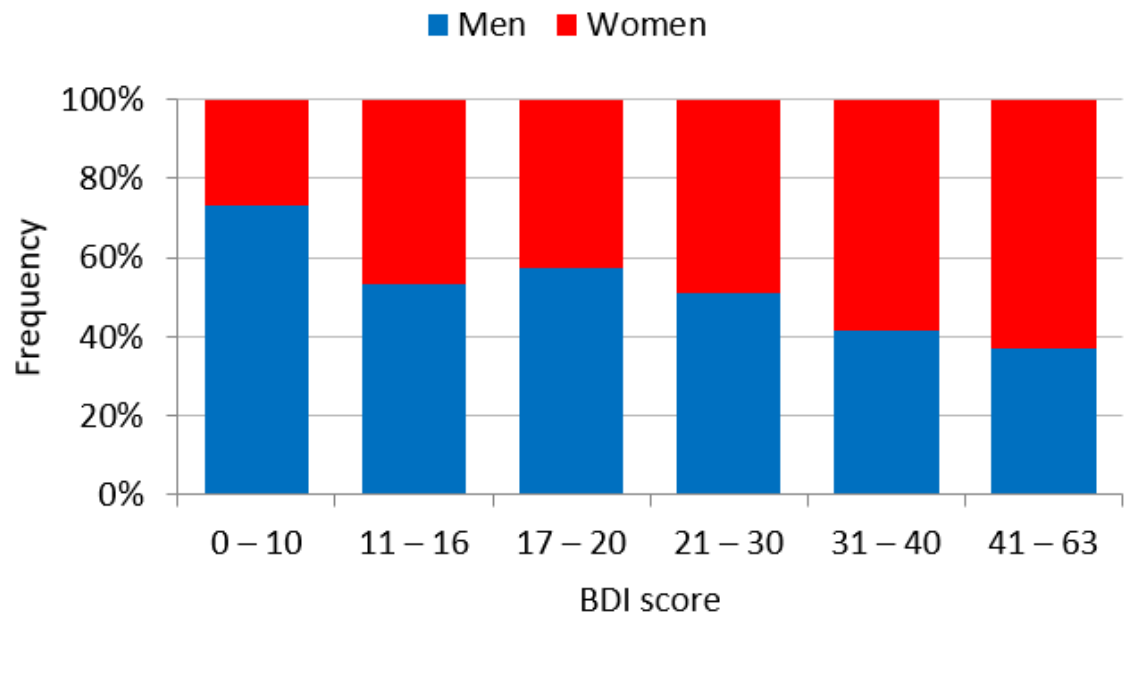
Figure 7. Beck Depression Inventory (BDI) test completion time